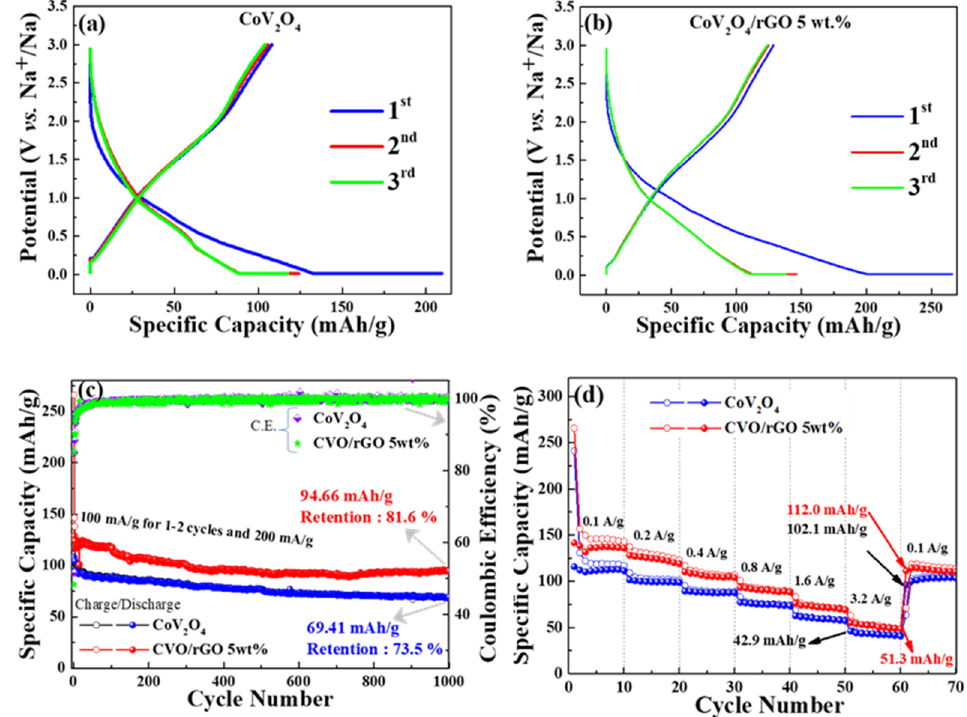
Figure 5. Electrochemical performance of Na ion storage: ( a , b ) discharge / charge profile of bare CoV 2 O 4 and rGO-wrapped CoV 2 O 4 electrodes; ( c , d ) cyclic stability and rate capability of bare CoV 2 O 4 and rGO-wrapped CoV 2 O 4 electrodes .